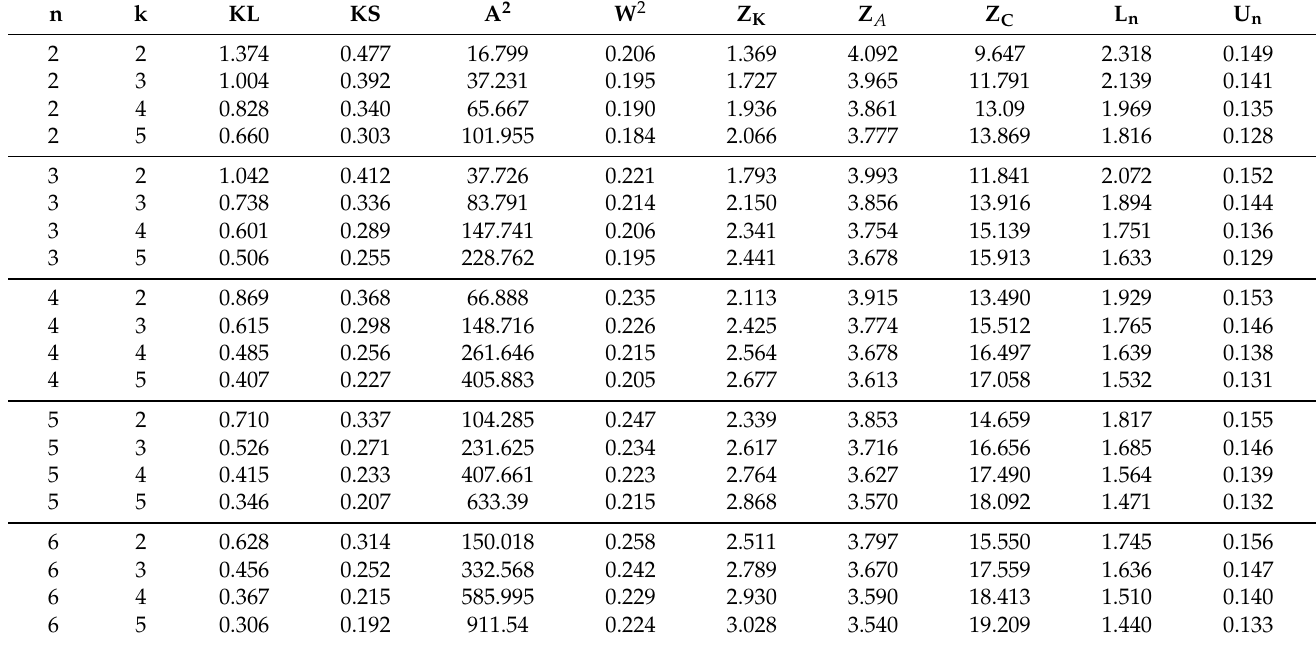
Table 2. The CV values of different tests of WGQLD for some values of ( n , k ) in RSS, at significance level of γ =